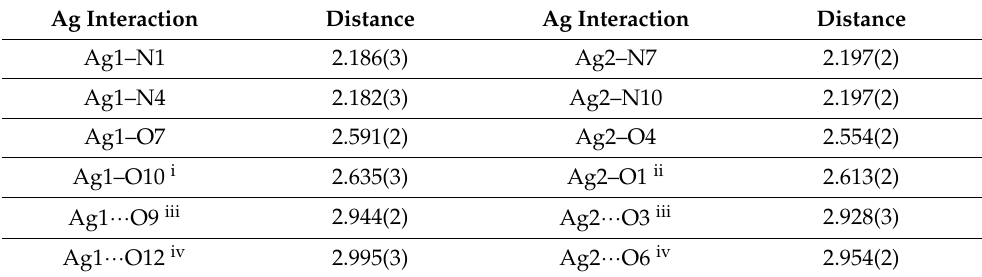
Table 1. Distances of Ag interactions (Å).